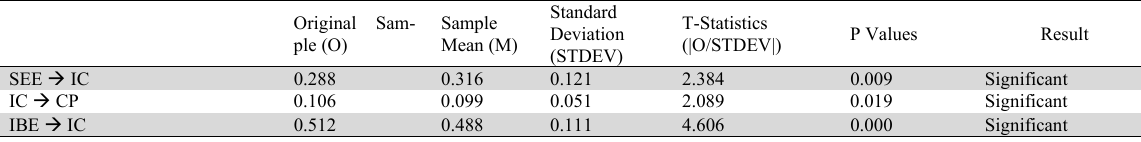
Direct Influence Test Results